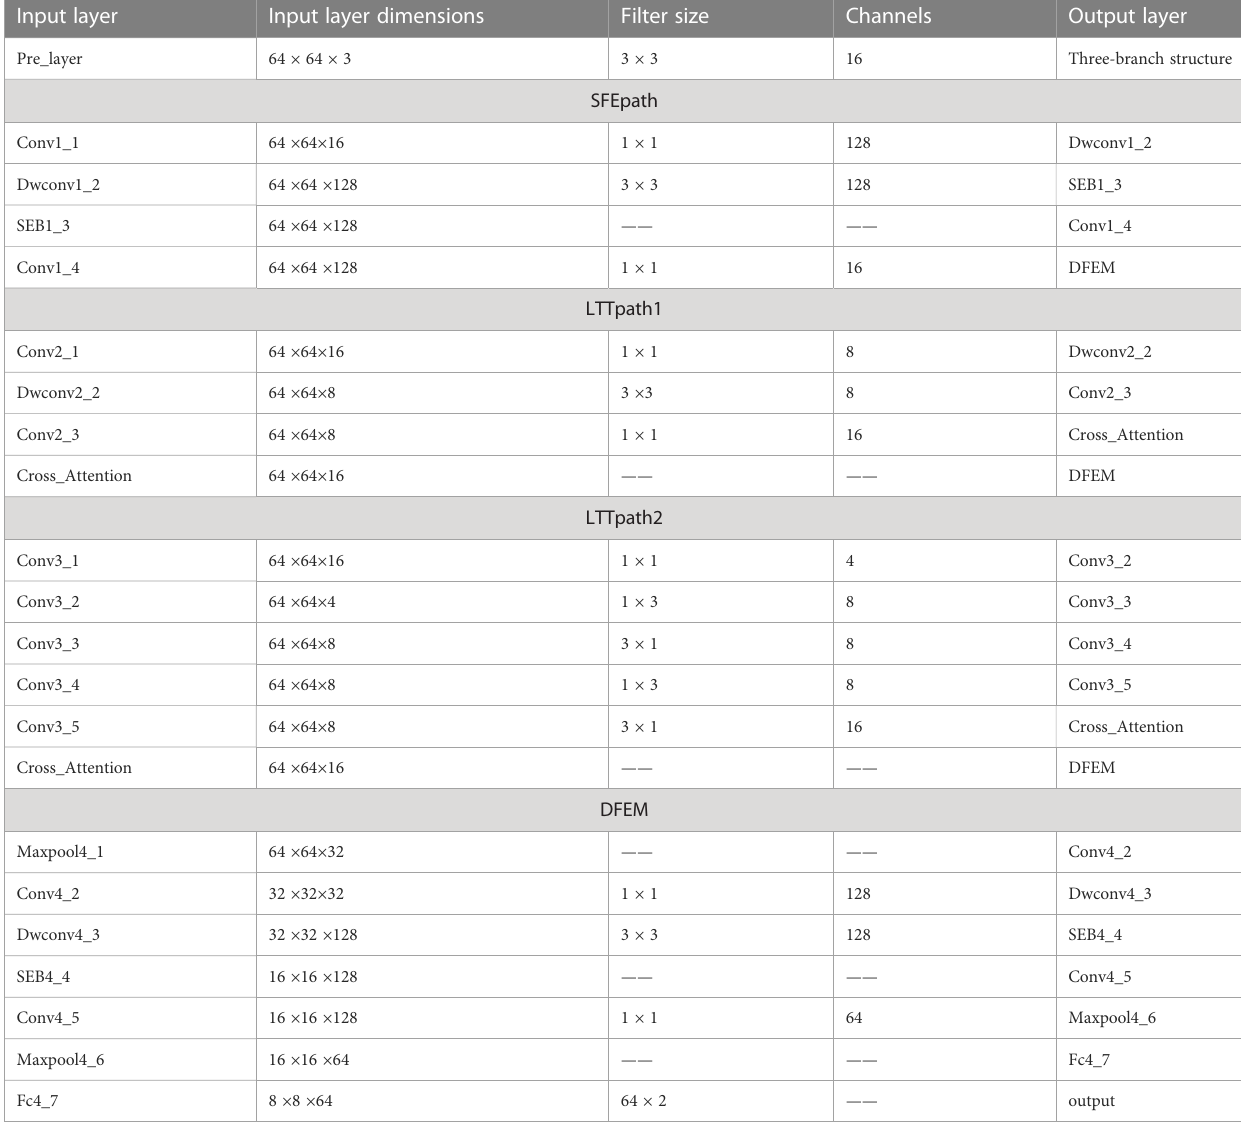
TABLE 2 Parameter con fi gurations of different